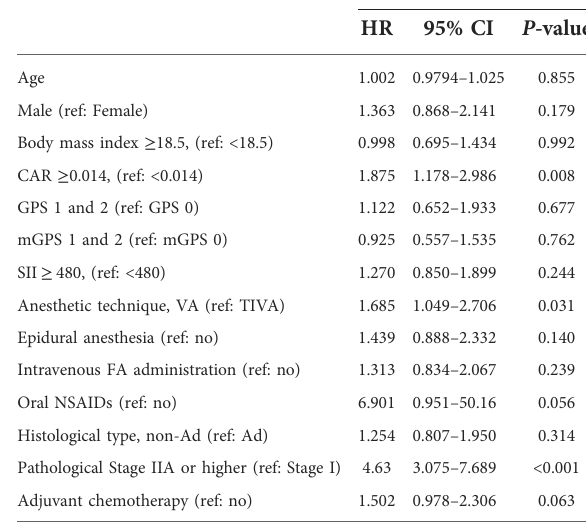
TABLE 2 Multivariate Cox analyses of